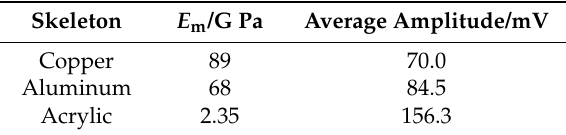
Table 3. Average amplitude of broken lead signal detected by FOR AE sensor.